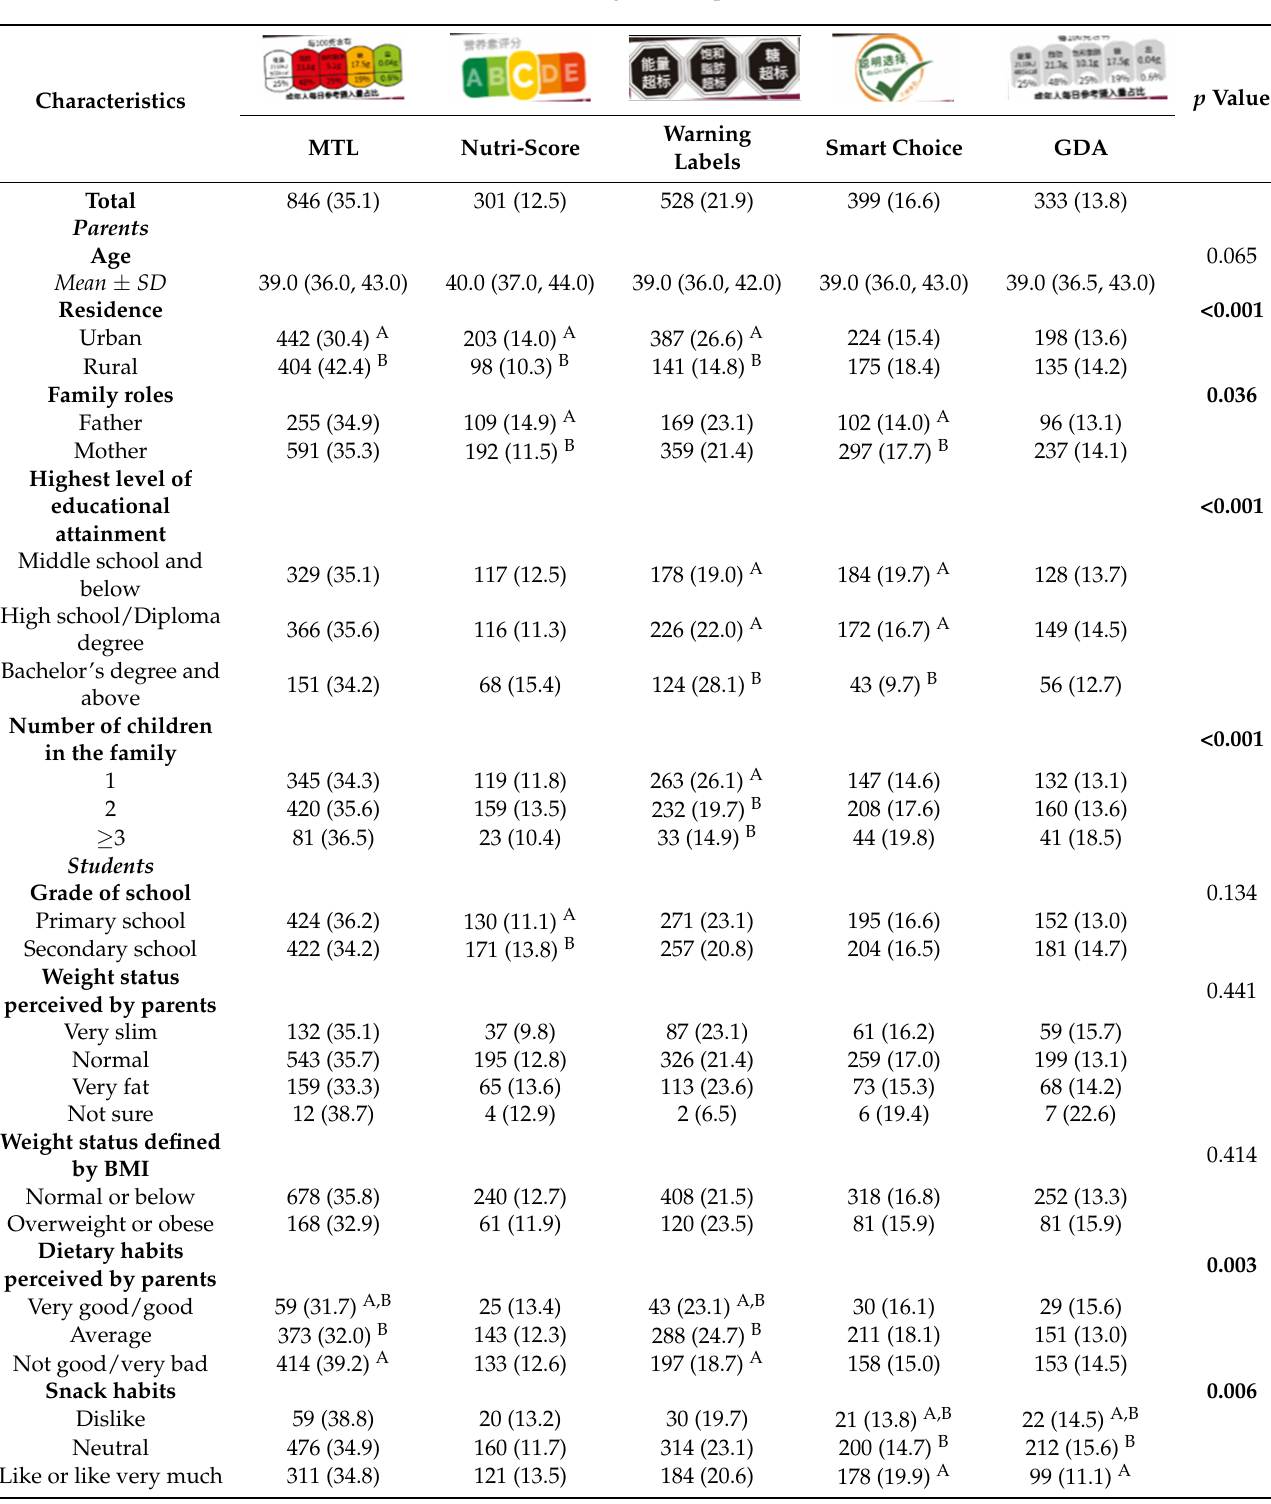
Table 2. FOPL format attracting Chinese parents most: n